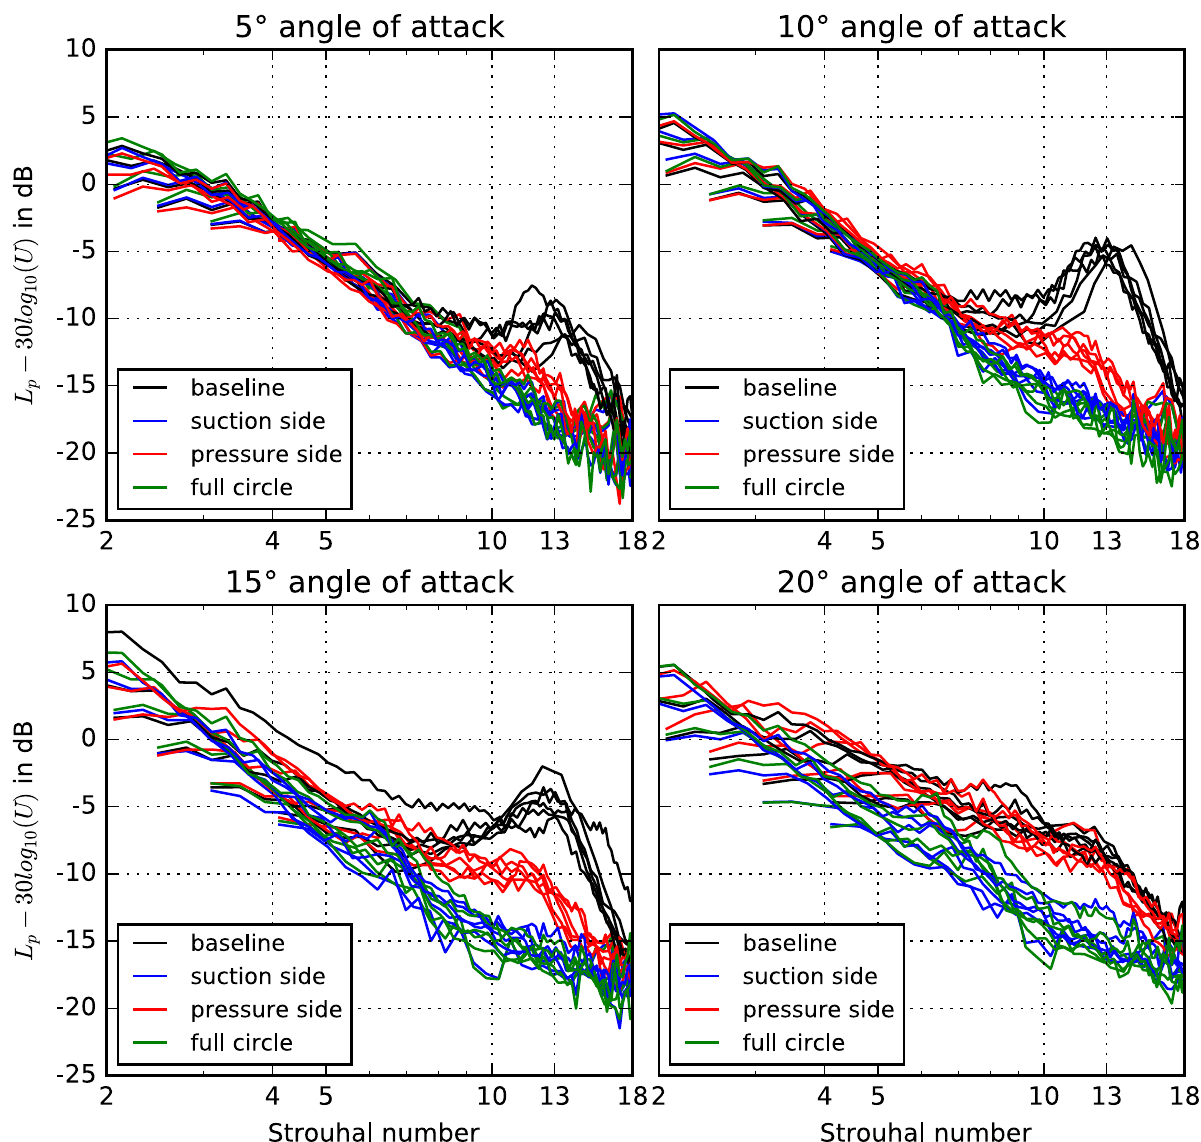
Figure 4. Velocity-scaled sound pressure levels integrated over whole airfoil for all con fi gurations and fl ow speeds for different angles of